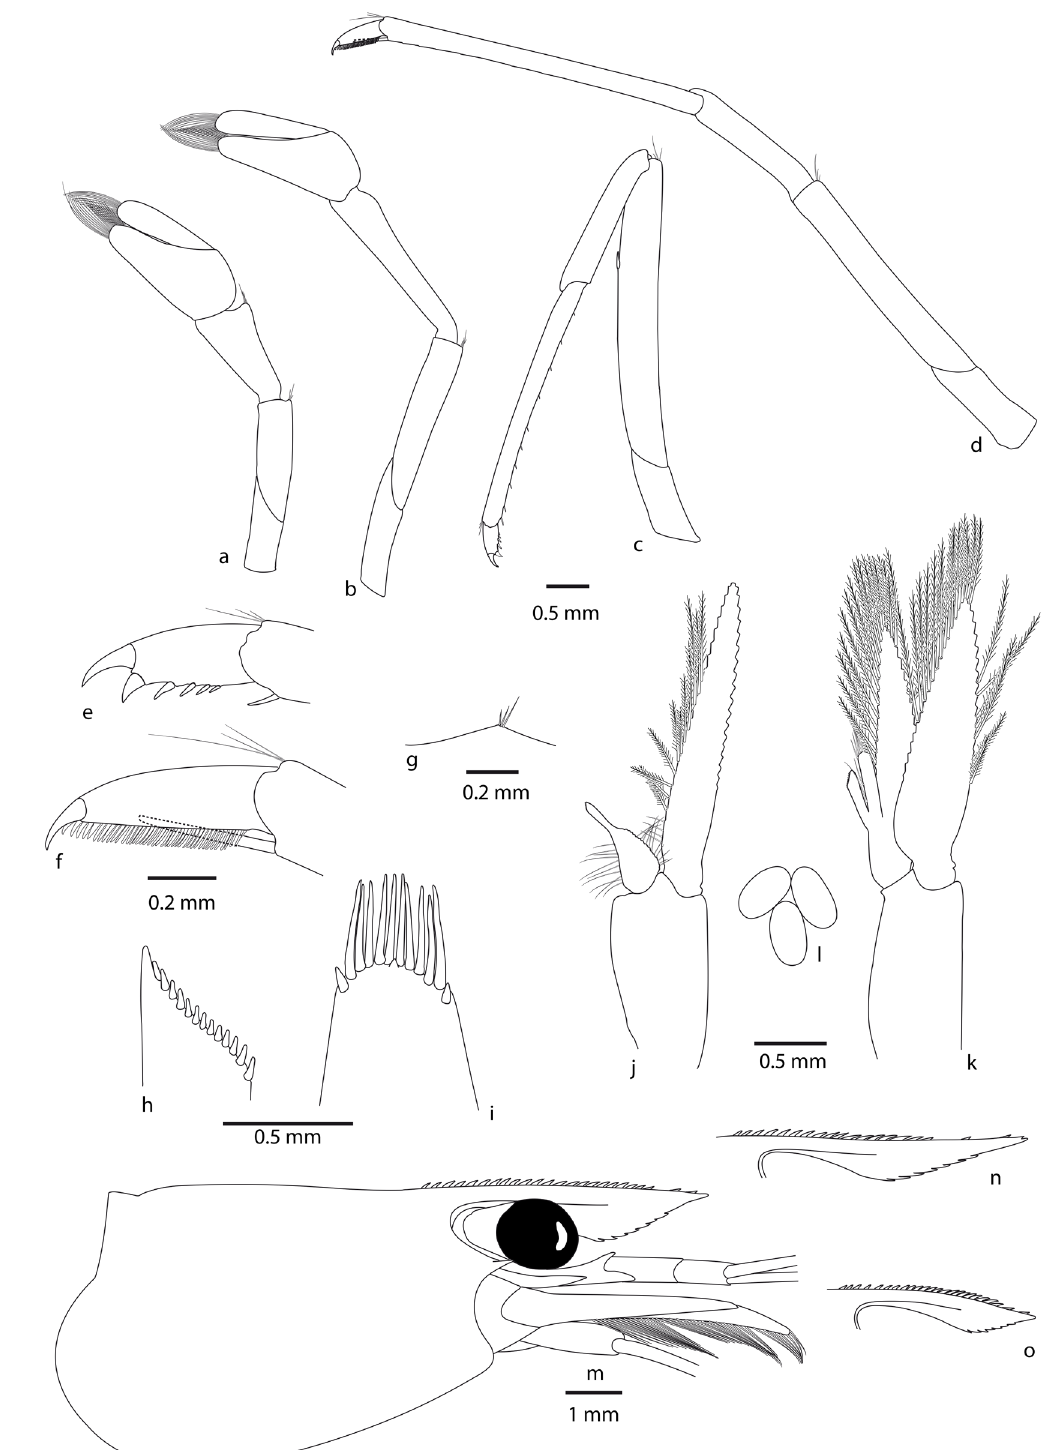
Fig. 8. Caridina mertoni Roux, 1911. a . First pereiopod. b . Second pereiopod. c . Third pereiopod. d . Fifth pereiopod. e . Dactylus of third pereiopod. f . Dactylus of fifth pereiopod. g . Pre-anal carina. h . Uropodal diaeresis. i . Telson. j . First male pleopod. k . Second male pleopod. l . Eggs. m .